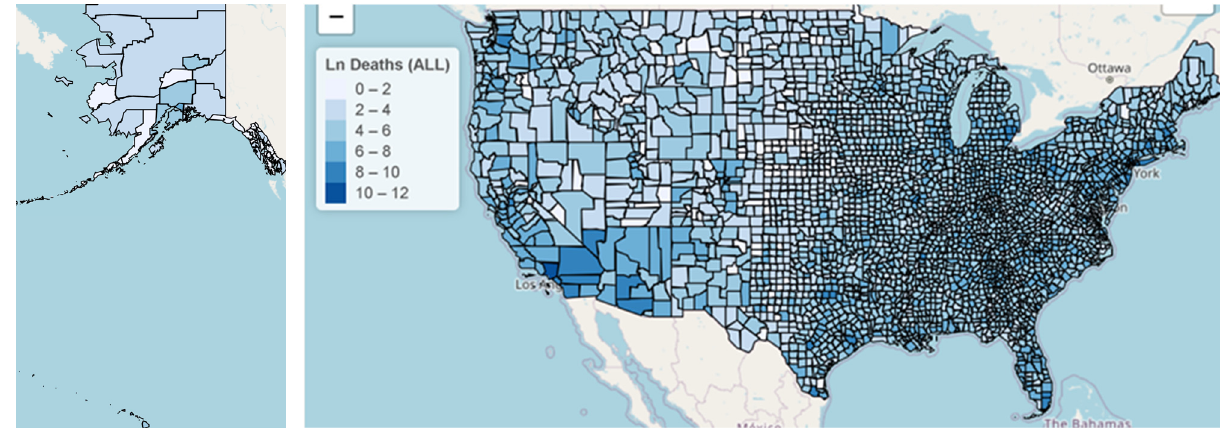
Figure 5. COVID-19 Logarithm of the Sum of Deaths (+1).